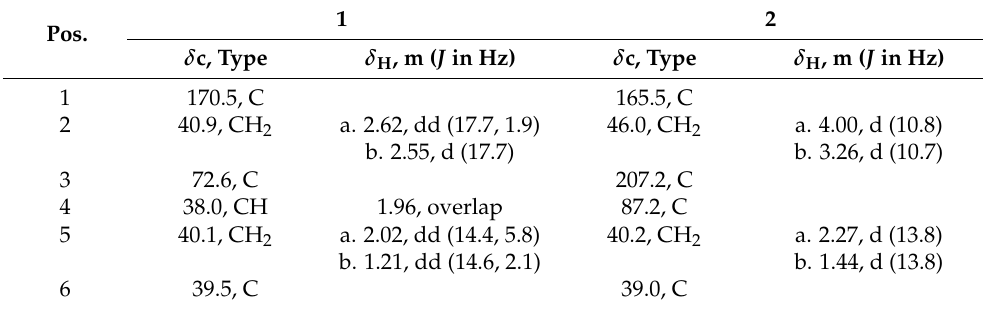
Table 1. 1 H (600 MHz) and 13 C (150 MHz) NMR data for compounds 1 and 2 in CDCl 3 ( δ in ppm). Pos.